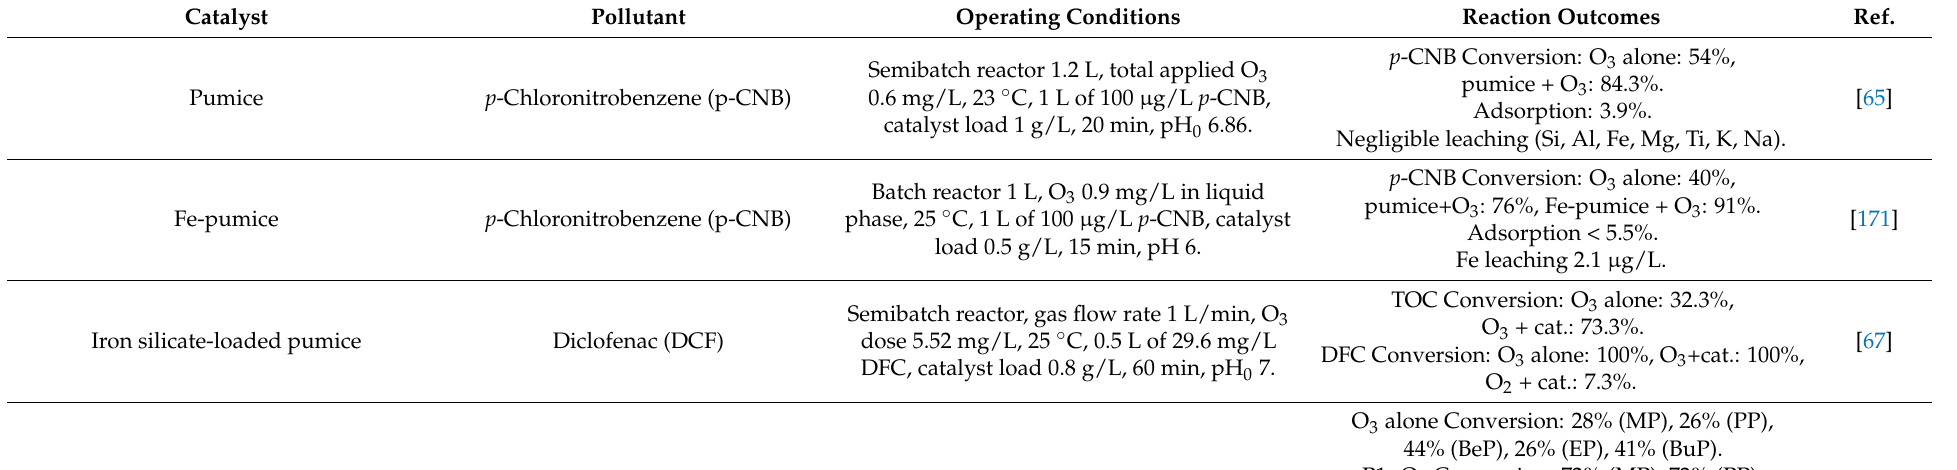
Table 4. Other minerals as catalysts in the ozonation of organic